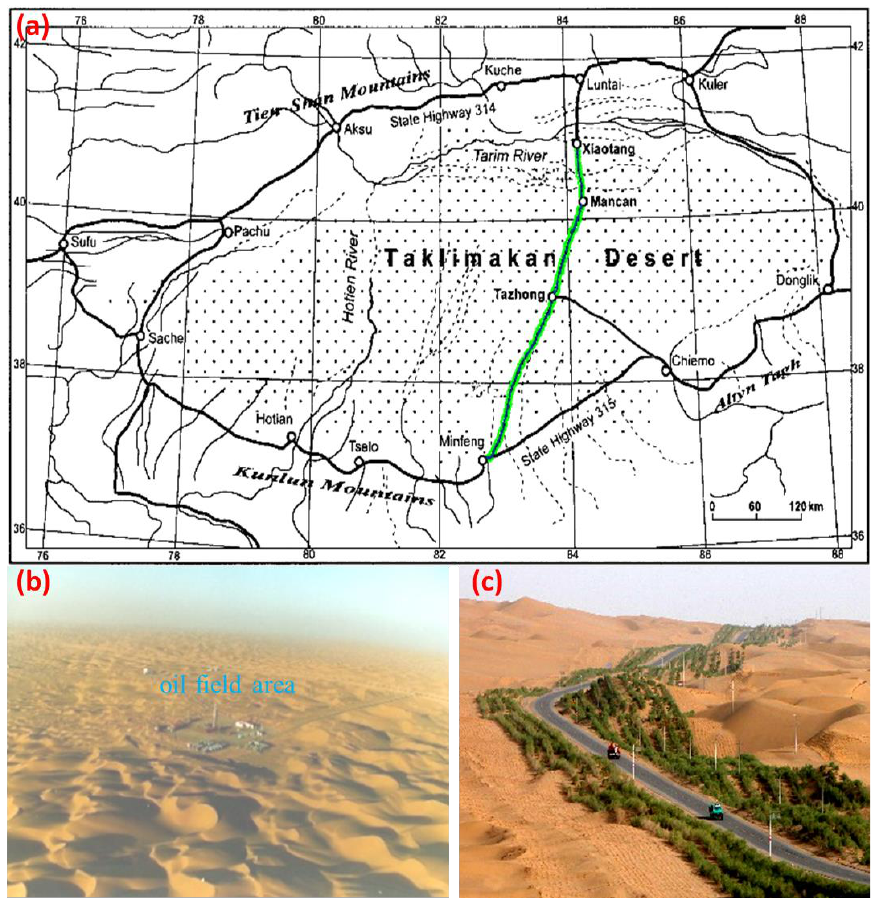
Figure 1. The Taklimakan Desert Highway Shelterbelt across a shifting-sand desert: The highway links Luntai and Minfeng on the northern and southern edges of the Tarim Basin (562 km). The greenbelts on both sides of the highway represent the artificial vegetation establishment ( a ), the oil field area — more than 98% of areas were covered with shifting dunes before the shelterbelt’s construction along the Taklimakan Desert Highway ( b ), and the greenbelt today ( c ).